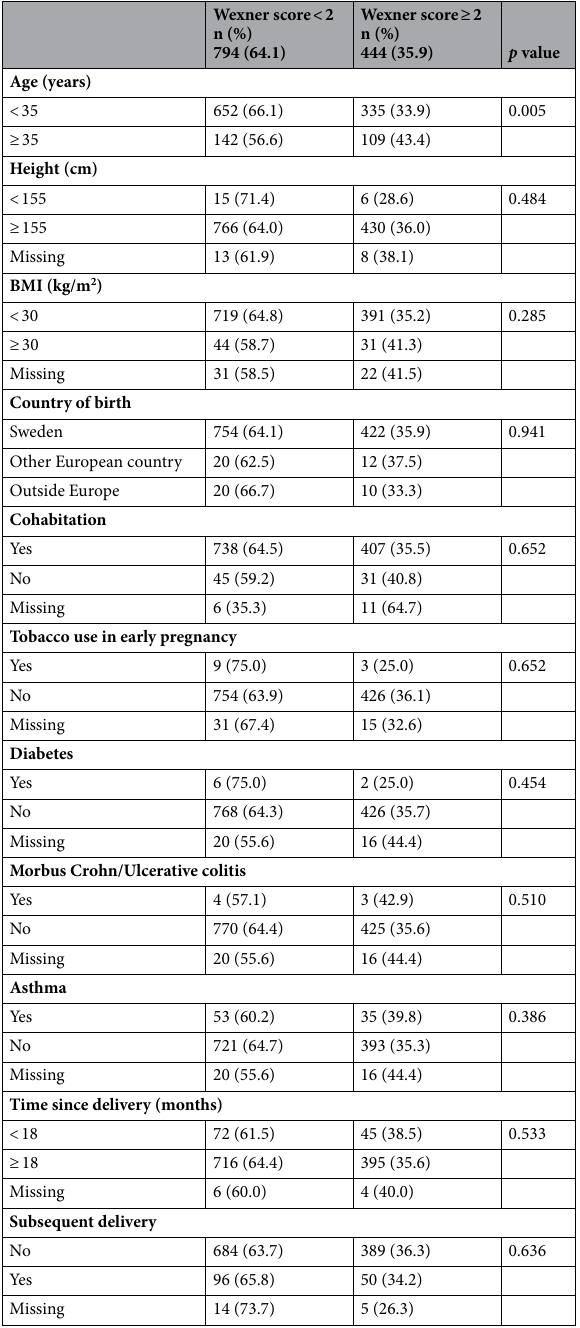
Table 1. Characteristics of women with Wexner score < 2 and ≥ 2. 64 women (4.9%) had missing data on Wexner score. Missing values presented when prevalent. P values are calculated using Chi 2 tests excluding missing